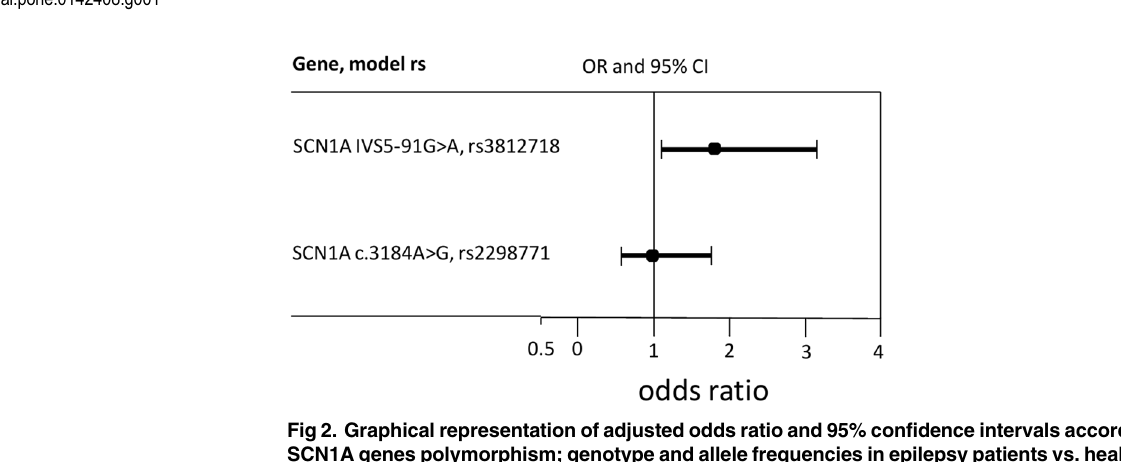
Fig 1. Correlation between CBZ and CBZE plasma concentrations (Pearson ’ s correlation coefficient R).